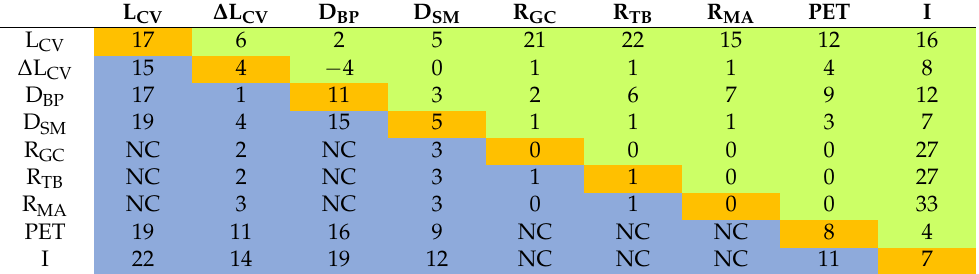
Table 2. Correlation analysis. Diagonal shows the memory effect (in number of time-steps) when simple correlation is calculated (orange). When cross-correlation is calculated, blue cells show memory effect and green cells show response time. NC means that correlation score is always under 0.2, showing a very weak correlation, leading to possible misinterpretations of the memory effect. L CV ∆ L CV D BP D SM R